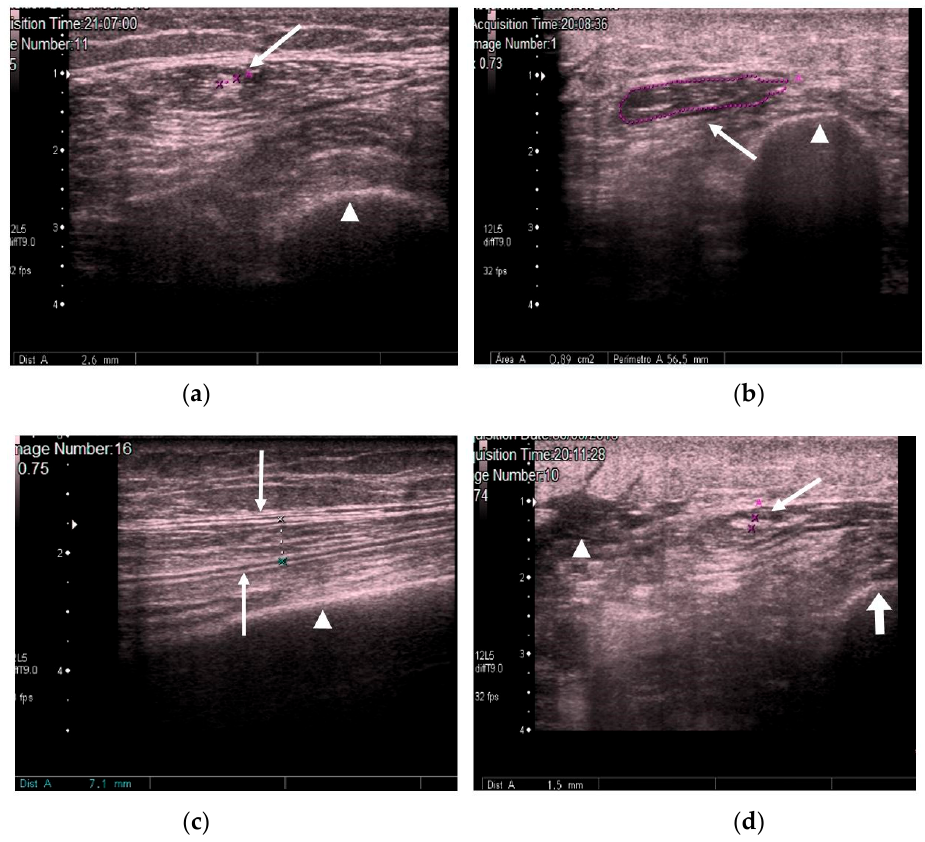
Figure 2. ( a ) Transversal QRF muscle US scan: multiorgan failure, tendon thickness of 2.6 mm (arrow), and femur (arrowhead). ( b ) Transversal QRF muscle US scan: multiorgan failure, cross-sectional area (CSA) of 0.89 cm 2 (arrow), and femur (arrowhead). ( c ) Longitudinal QRF muscle US scan: muscle thickness of 7.1 mm (arrow) and femur (arrowhead). ( d ) Longitudinal QRF muscle US scan: subcutaneous edema, with intramuscular and interfacial fluid (arrowhead). QRF tendon is 1.5 mm (arrow) with the femur (thick arrow). QRF: quadriceps rectus femoris, US: ultrasound, CSA: cross-sectional